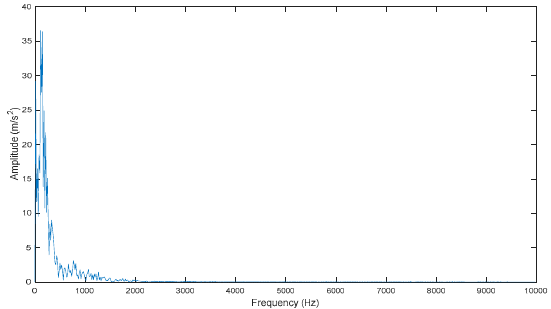
Figure 16. Octave frequency of the real signal.